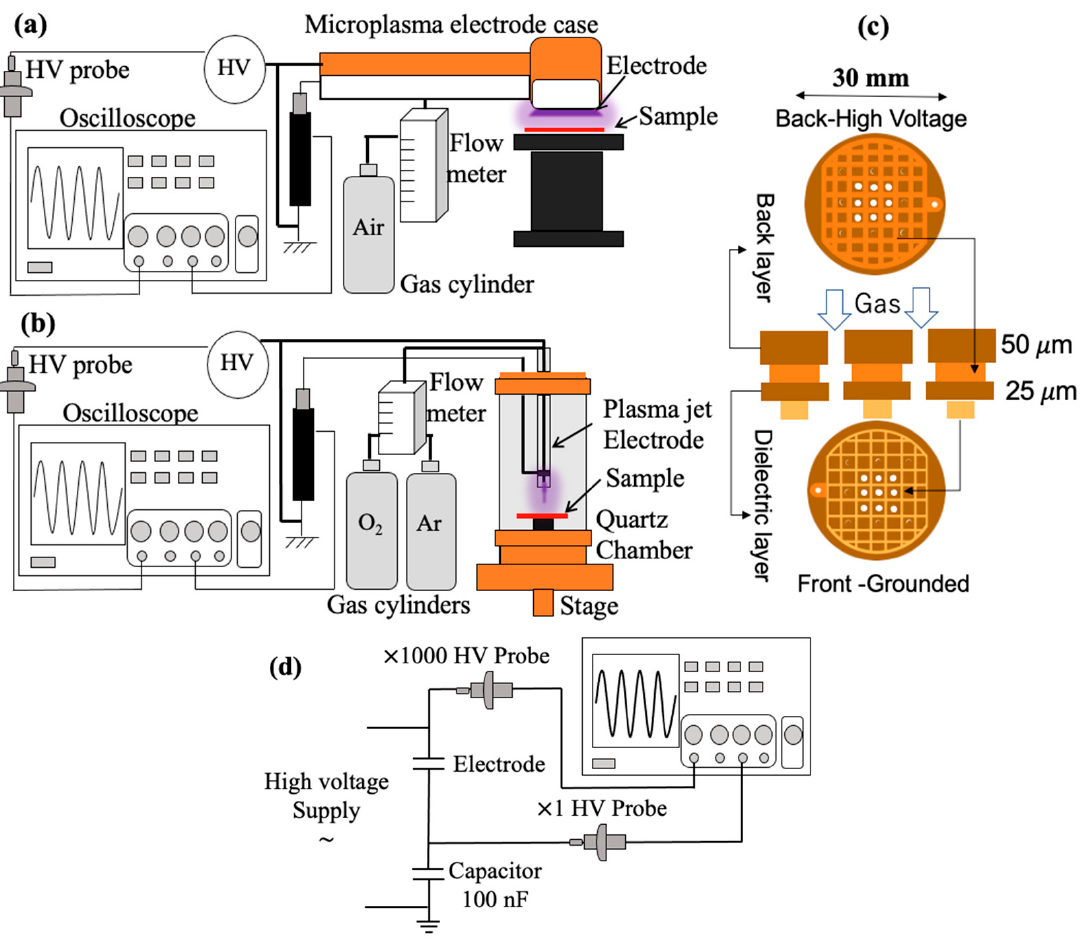
Figure 4. ( a ) DBD microplasma setup, ( b ) DBD microplasma electrode geometry, ( c ) plasma jet setup, and ( d ) transferred charge measurement